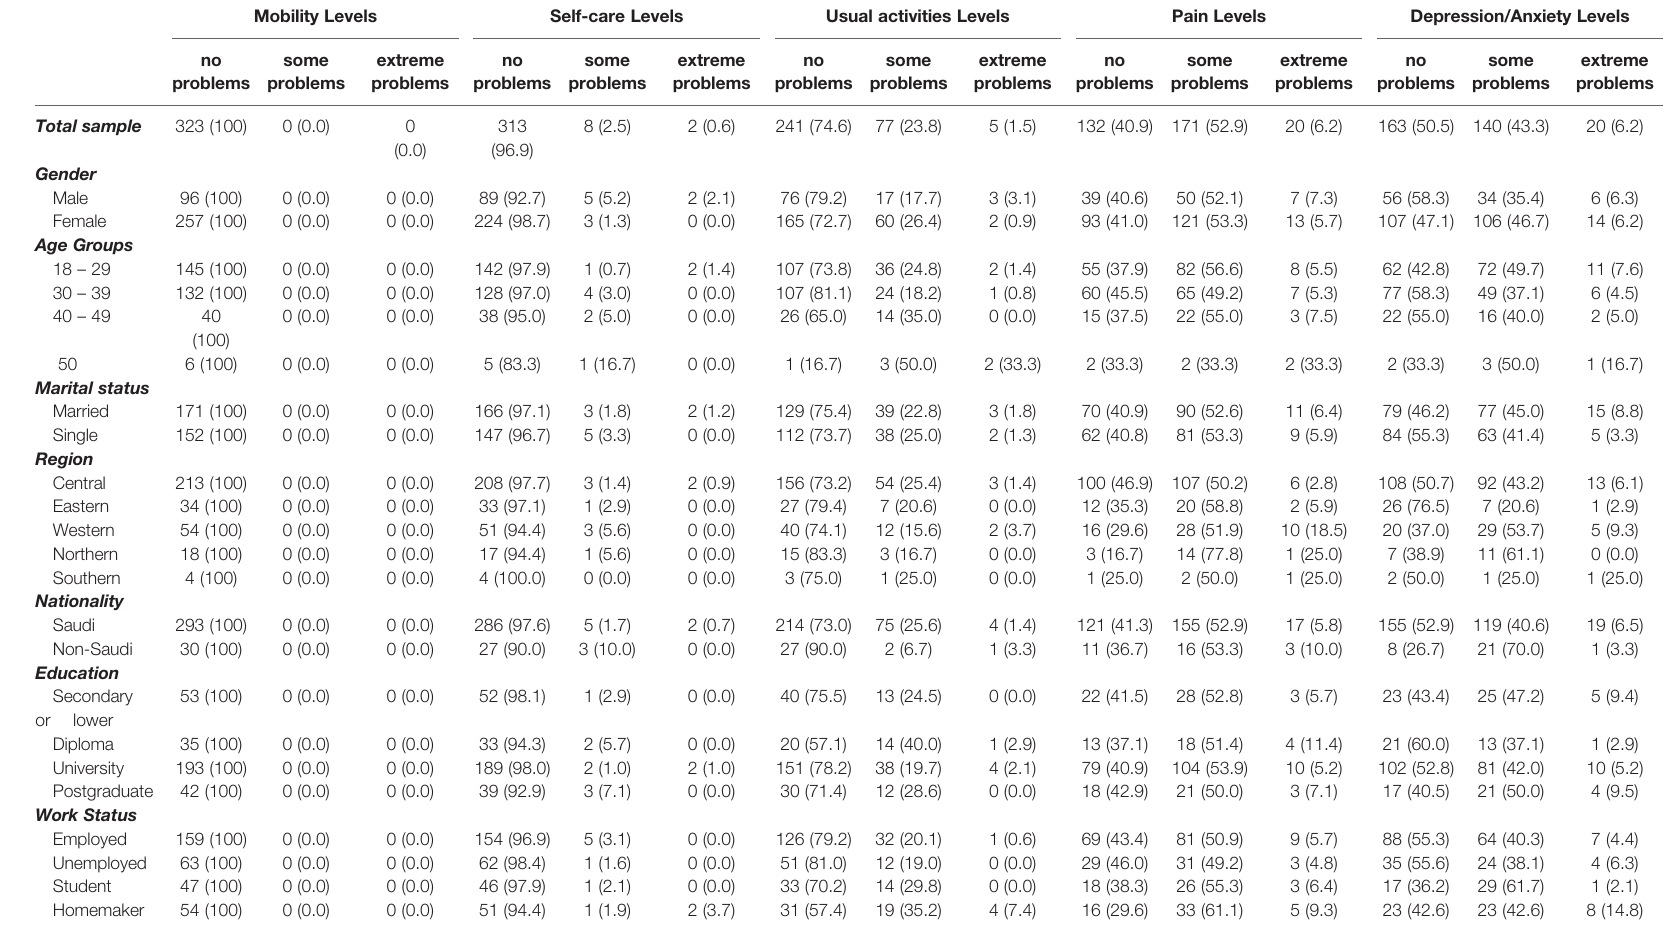
TABLE 3 | Frequency Distribution of EQ-5D 3L of the Total Sample and by patients' Characteristics; N